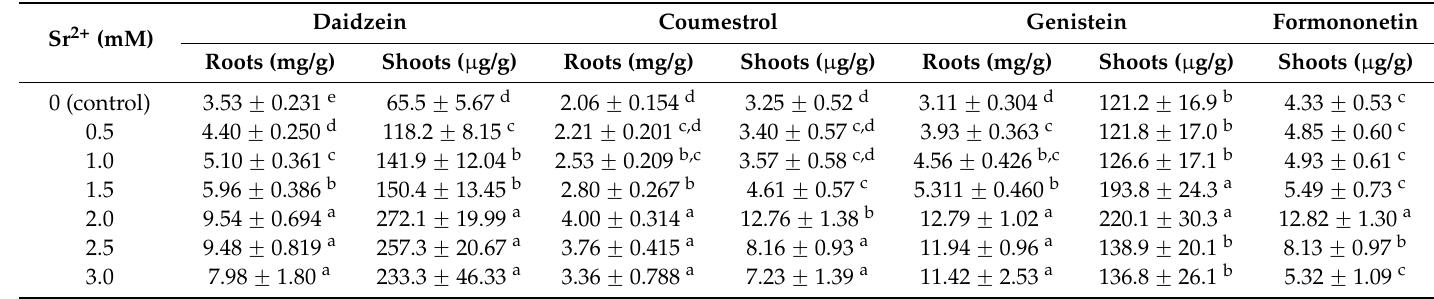
Different letters within each column indicate significant differences by Fisher’s test at p <